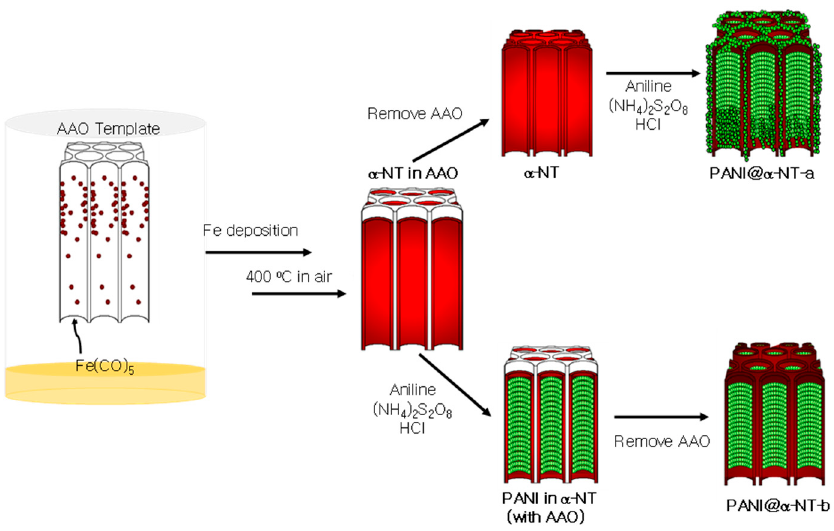
Scheme 1. Schematic illustration of α -Fe 2 O 3 nanotube ( α -NT), PANI@ α -NT-a, and PANI@ α -NT-b fabrication.